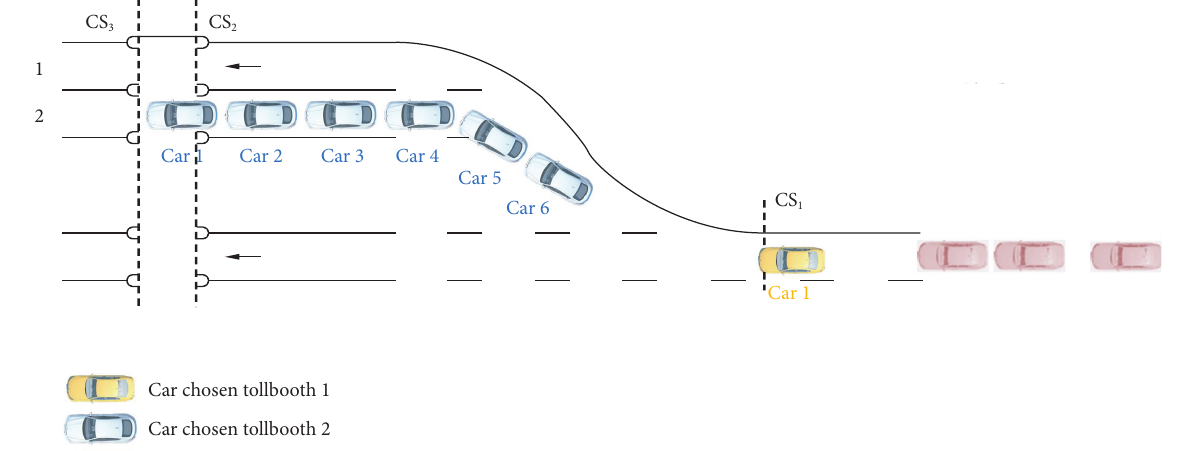
Figure 19: Formation and clearance of the blockage from queues of other tollbooths: (a) At time t blocked. (b) At time t a , q 1 1 q 2 1 ( t ) ≥ q B , car 2 is still c 2 2